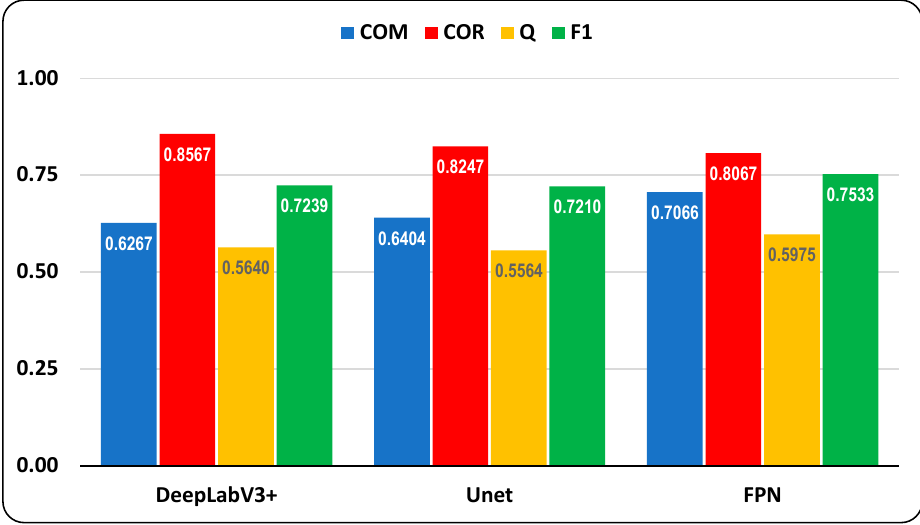
Figure 9. Rural road detection average metrics evaluation for the test dataset. Comparing the three models: (i) DeepLabV3+ achieved the highest average correct- ness score of the tree models; (ii) Unet achieved a lower score compared to DeepLabV3+; and (iii) FPN, does not outperform any of the highest scores; and FPN achieved the high-